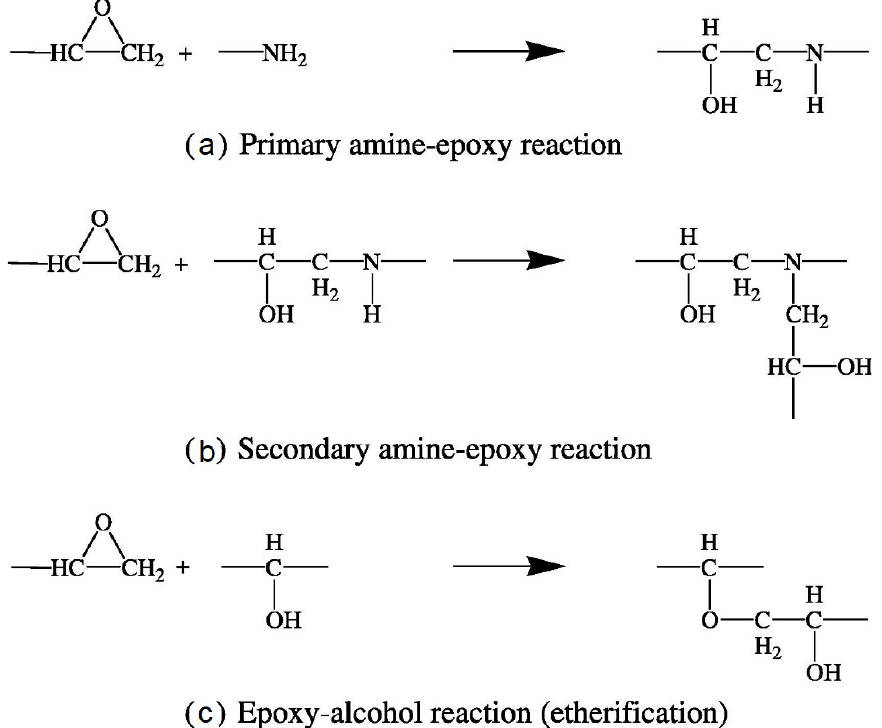
Figure 1. Mechanism of epoxy curing [17].